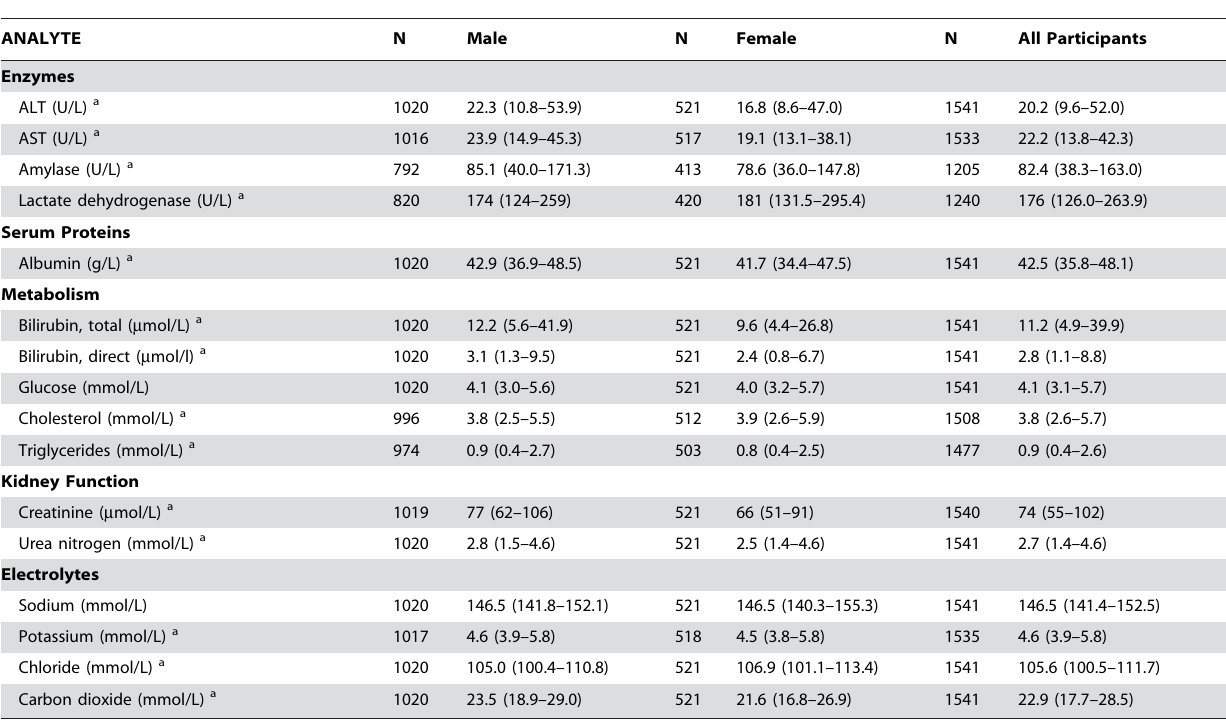
Table 3. Clinical Chemistry reference ranges (median and 95th-percentile) derived from HIV-seronegative adults in Kericho, Kenya.